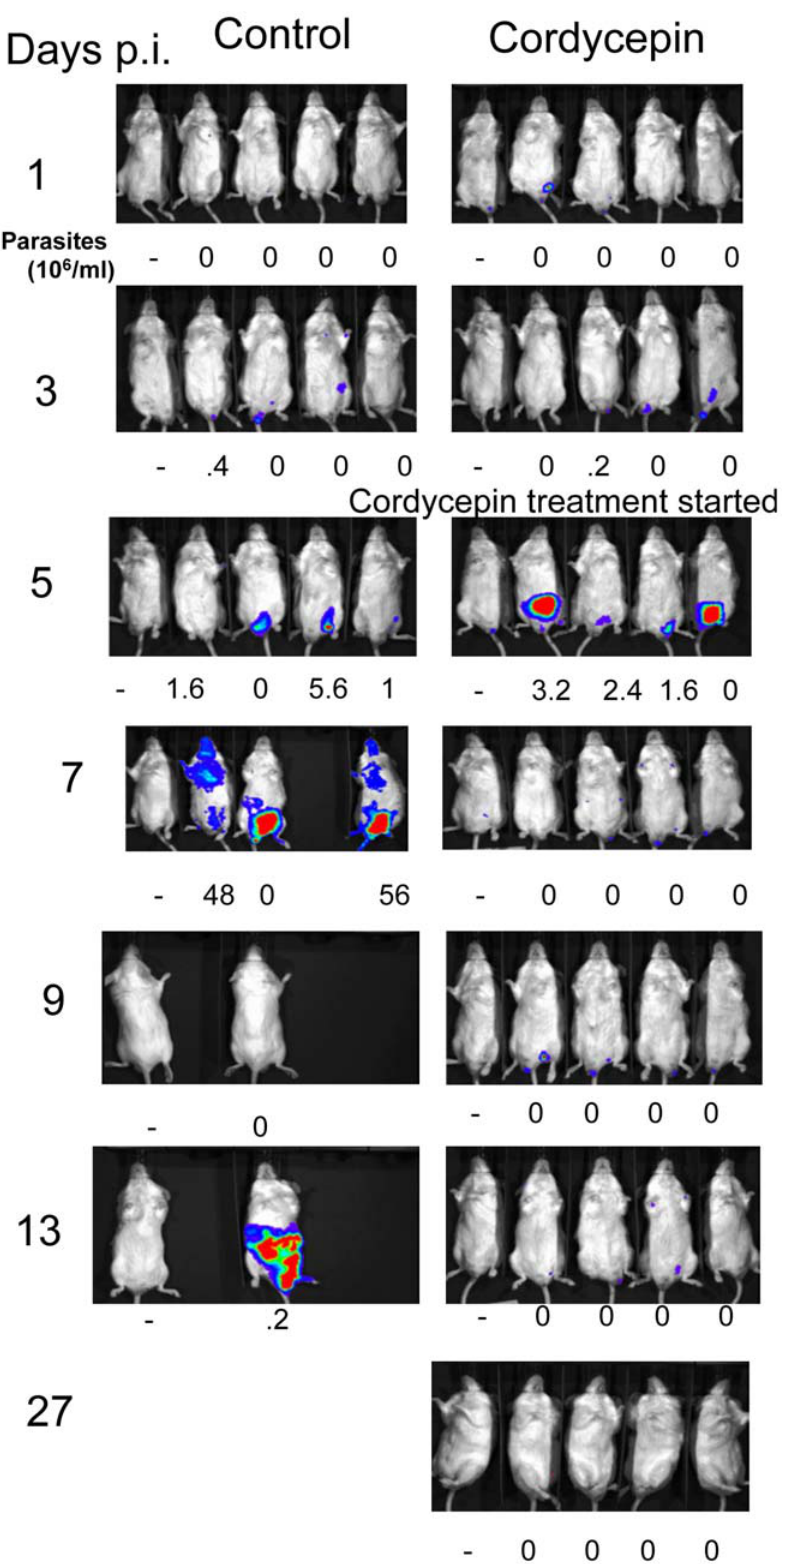
Figure 6. Curative treatments with cordycepin and deoxycoformycin shows disappearing light signals. Kinetics of infection of BALB/c male mice with recombinant T.b. brucei Lister 427. BALB/c mice were infected ip with 100 T.b. brucei Lister 427. Five days after infection mice were treated i.p. with 2 mg/kg cordycepin daily for 7 days. Parasite load was measured by bioluminescence imaging and parasitemia was registered.